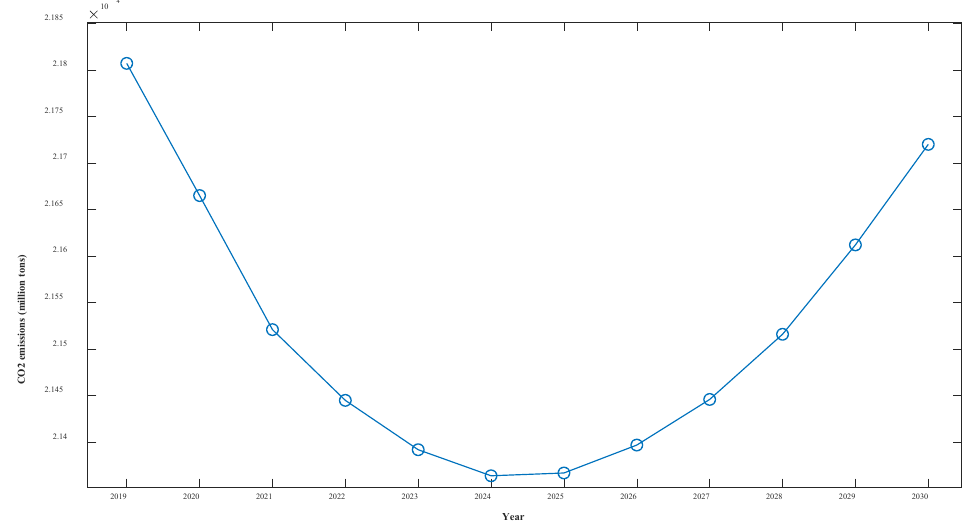
Figure 11. Overall CO 2 emissions curve for Shaanxi Province over the next 11 years. From the forecast results, four industries, PNGE, TSPTS, SPFM, and NMMD, show a larger proportional CO 2 emissions decrease, with emissions expected to drop by more than 50% by 2030. This situation will undoubtedly contribute significantly to the accomplishment of CO 2 emissions reduction and carbon neutrality targets, but it is not consistent with the actual situation in Shaanxi Province, where the pace of CO 2 emissions reduction is too